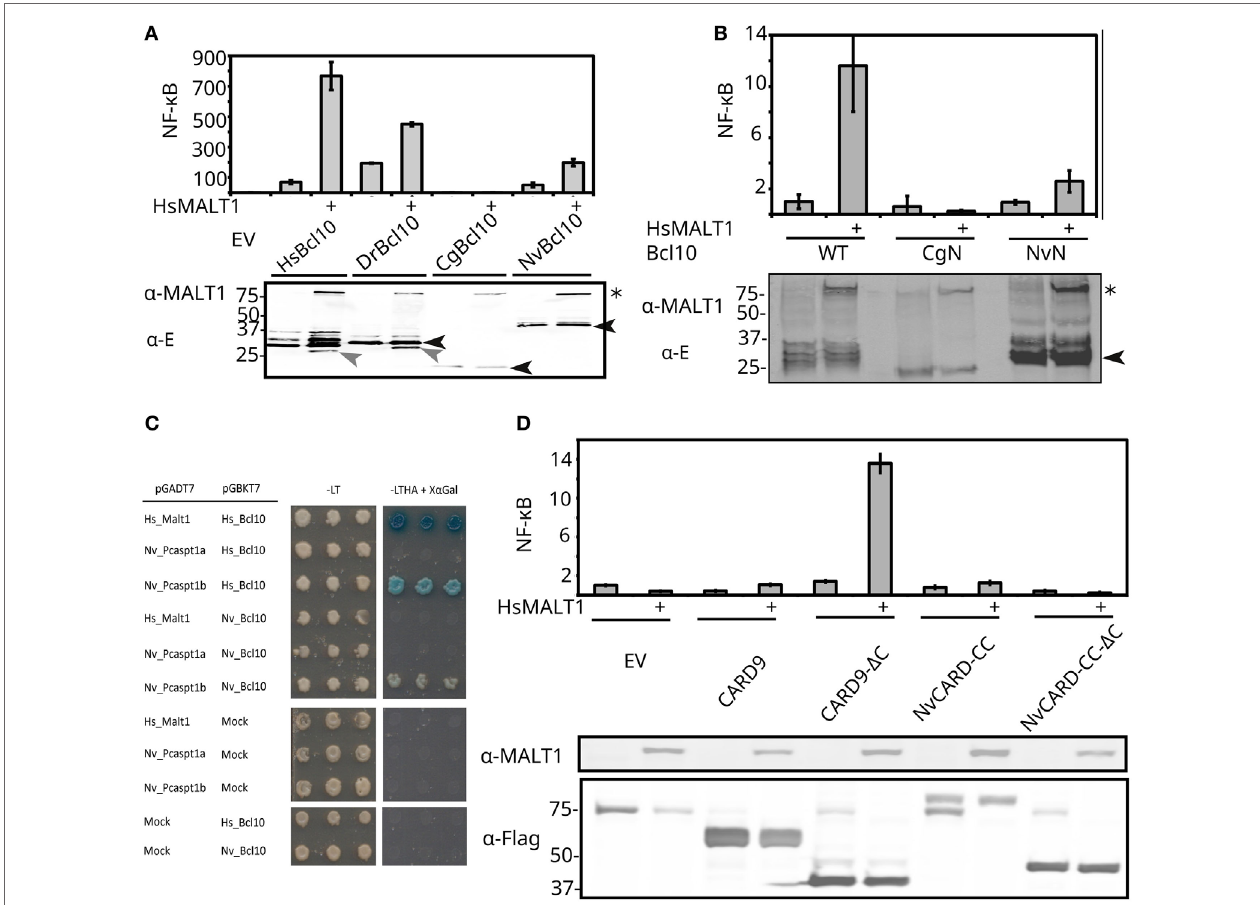
FigUre 5 | Functional conservation of Bcl10 and CARD–CC proteins. (a) Human MALT1-dependent NF- κ B induction by different Bcl10 homologs. The indicated E-tagged Bcl10 homologs were expressed in MALT1-deficient HEK293T cells together with an NF- κ B-dependent luciferase reporter expression plasmid and a constituitively expressed β -galactosidase reporter gene. Where indicated ( + ), human MALT1 was also co-expressed. Luciferase values were normalized against β -galactosidase and expressed as fold induction compared to samples not expressing Bcl10 (EV). Error bars represent 95% confidence intervals (Student’s t -distribution). The expression of E-tagged Bcl10 homologs and human MALT1 was revealed by Western blotting and detection with anti-E-tag or anti-MALT1 antibodies, respectively (lower part). Full-length Bcl10 is indicated by closed arrow heads and cleaved Bcl10 by open arrow heads. MALT1 is indicated by an asterisk. Experiments were repeated two times. (B) Bcl10/CARD-dependent MALT1-mediated NF- κ B induction. Wild-type human Bcl10 and hybrid Bcl10 clones where residues 1–102 of human Bcl10 were replaced by the corresponding residues from C. gigas (CgN) or Nematostella vectensis (NvN) Bcl10 were expressed in MALT1-deficient HEK293T cells together with an NF- κ B-dependent luciferase reporter expression plasmid and a constituitively expressed β -galactosidase reporter gene. Where indicated, ( + ) human MALT1 was also co-expressed. Luciferase values were normalized against β -galactosidase and expressed as fold induction compared to samples expressing human wild-type Bcl10 without MALT1. Experiments were repeated two times. (c) Yeast-2-hybrid assay demonstrating conserved interaction between both Nvn and human Bcl10 and type 1 paracaspases. Left panel represents growth on non-selective media and right panel selective growth (-LTHA medium), on which only a combination of bait and prey clones with interacting proteins can grow. As an independent readout, clones with strong bait–prey interactions also stain blue from X-gal. (D) Full-length and C-terminal deletion ( Δ C) constructs of human CARD-9 and Nvn CARD–CC were expressed in MALT1- deficient HEK293T cells together with NF- κ B-dependent luciferase reporter gene and constitutively expressed β -galactosidase reporter gene plasmids. Where indicated, ( + ) human MALT1 was also co-expressed. Luciferase values are normalized against β -galactosidase and expressed as fold induction compared to samples not expressing CARD-9 or CARD–CC (EV). Error bars represent 95% confidence intervals (Student’s t -distribution). The lower part of the panel shows the expression of full-length and Δ C-mutant CARD-9 and Nvn CARD–CC constructs, respectively, as revealed by Western blotting and development with anti-Flag antibodies. An aspecific Flag signal at 75 kDa is sometimes visible in the MALT1-deficient HEK293T cells. Experiments were repeated two